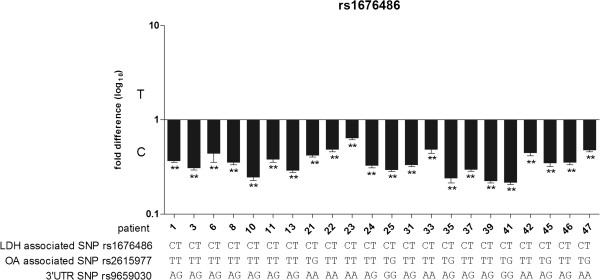
Allelic expression analysis in cartilage samples from OA patients assessed using the LDH associated SNP rs1676486. The genotypes of the patients at rs1676486, at the OA associated SNP rs2615977 and at the 3′UTR SNP rs9659030 are shown. P-values were calculated by comparing the cDNA allelic ratio to the DNA allelic ratio using a Mann–Whitney U test. ** denotes p < 0.01.